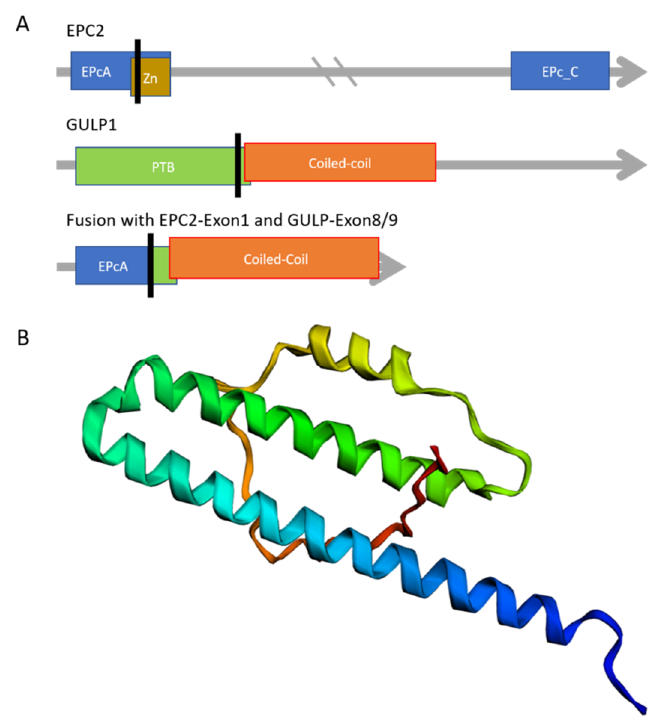
Figure 3. Possible composition of the EPC2–GULP1 fusion protein. ( A ) The fusion protein contains the 51 first amino acids of EPC2 and, therefore, the main part of the EPL1 domain, excluding the zinc finger domain (Zn). Known active domains of GULP1 are the phosphotyrosine binding (PTB) and a coiled-coil. The black line represents the breaking points and the position of fusion in the transcripts or proteins. ( B ) Structure of the fusion protein predicted by trRosetta. The α-helix represents the coiled-coil domain of GULP1. The TM-score had an estimated value of 0.264.